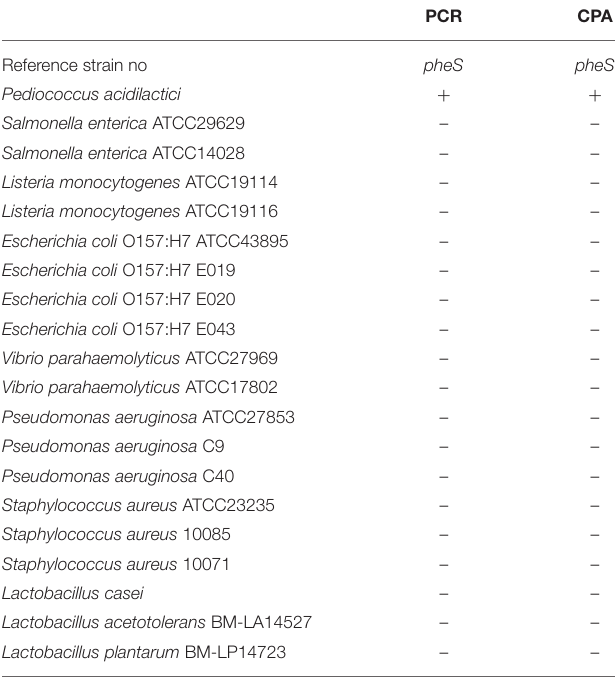
TABLE 2 | Reference strains and results of PCR and CPA